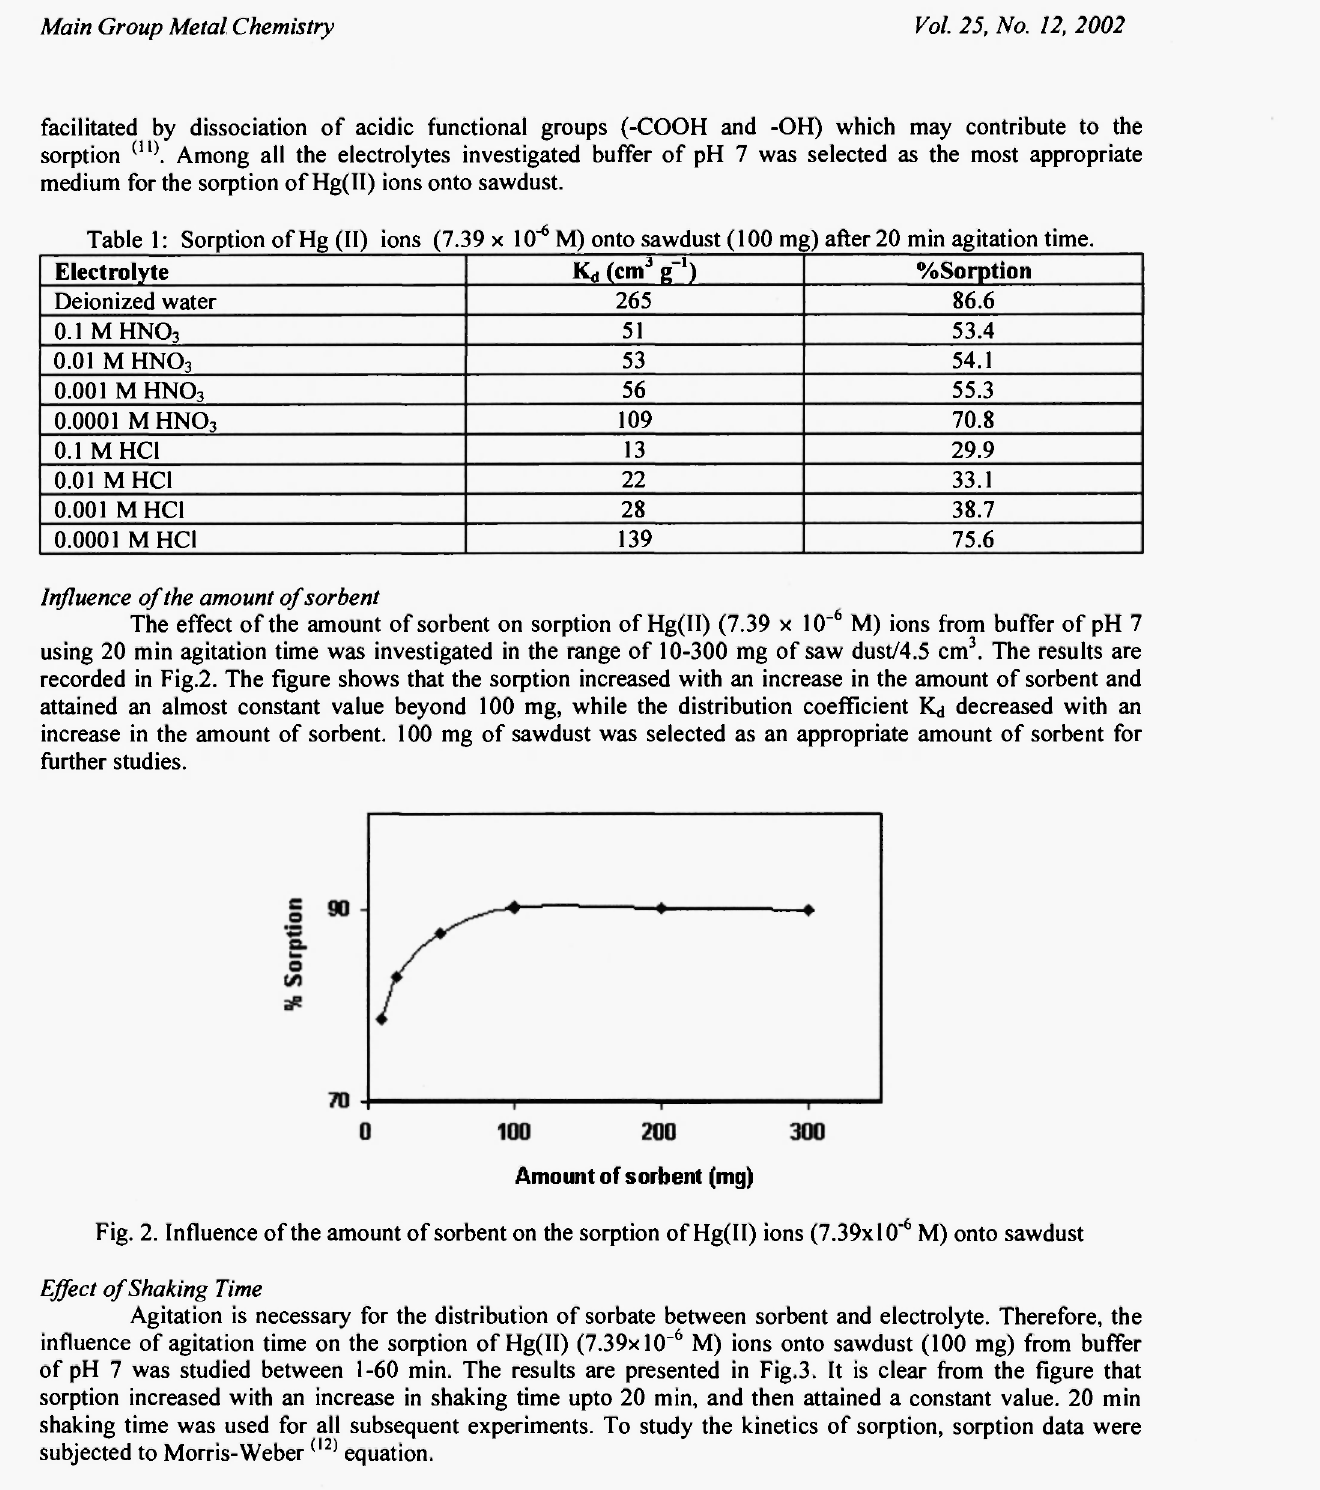
Table 1: Sorption of Hg (II) ions (7.39 χ 10" 6 Μ) onto sawdust (100 mg) after 20 min agitation time.